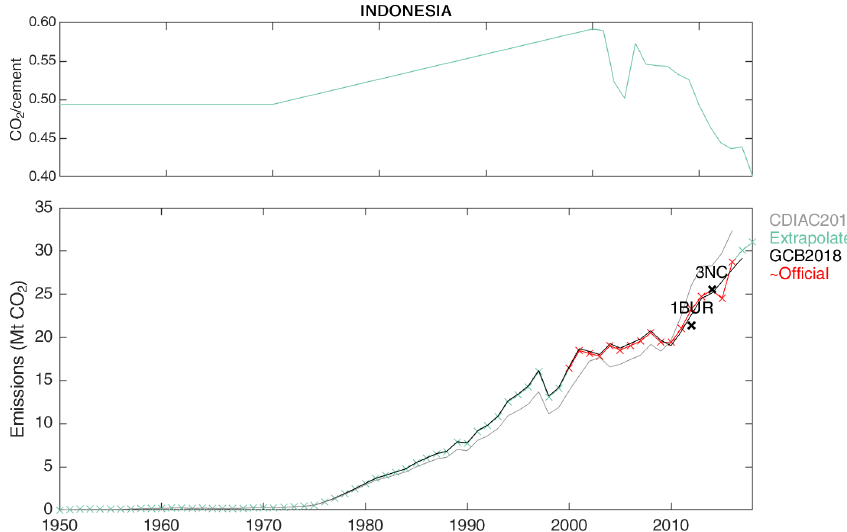
Figure C19. Revised cement emissions for Indonesia.